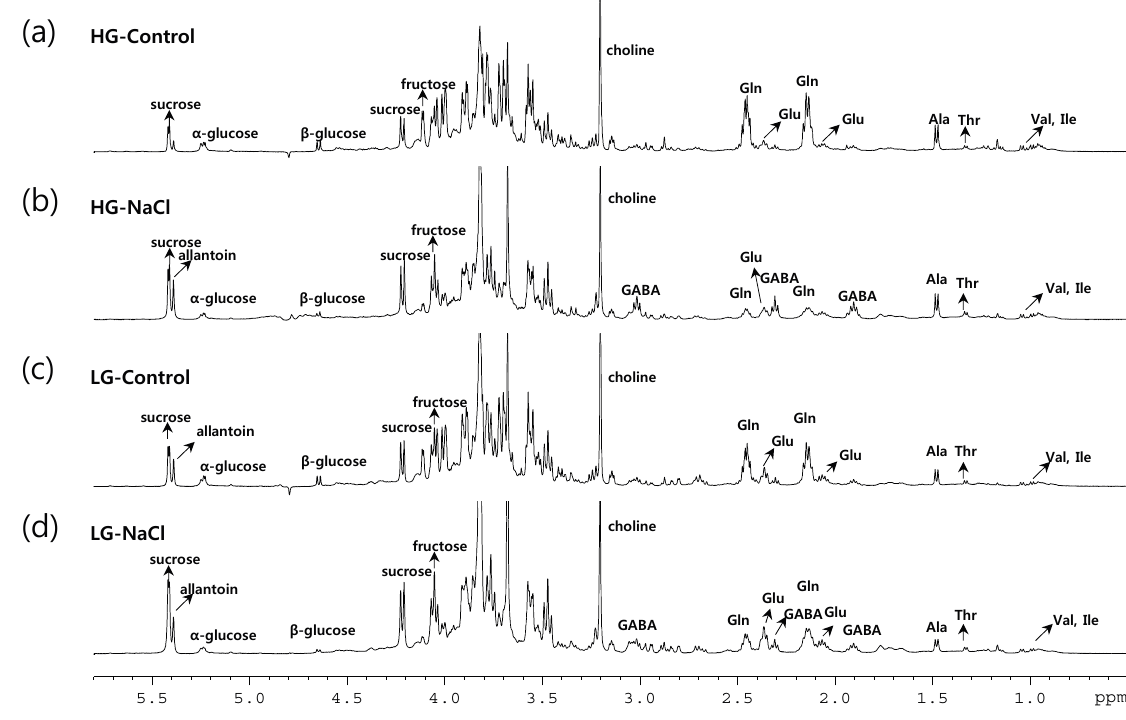
Figure 2. Typical 500-MHz 1 H-NMR spectra of the aqueous extract from the rice roots of the HG control ( a ); HG salt treated ( b ); LG control ( c ); and LG salt treated ( d ). Gln, glutamine; Glu, glutamate; Ala, alanine; Thr, threonine; Val, valine; Ile, isoleucine; GABA, γ -aminobutyric